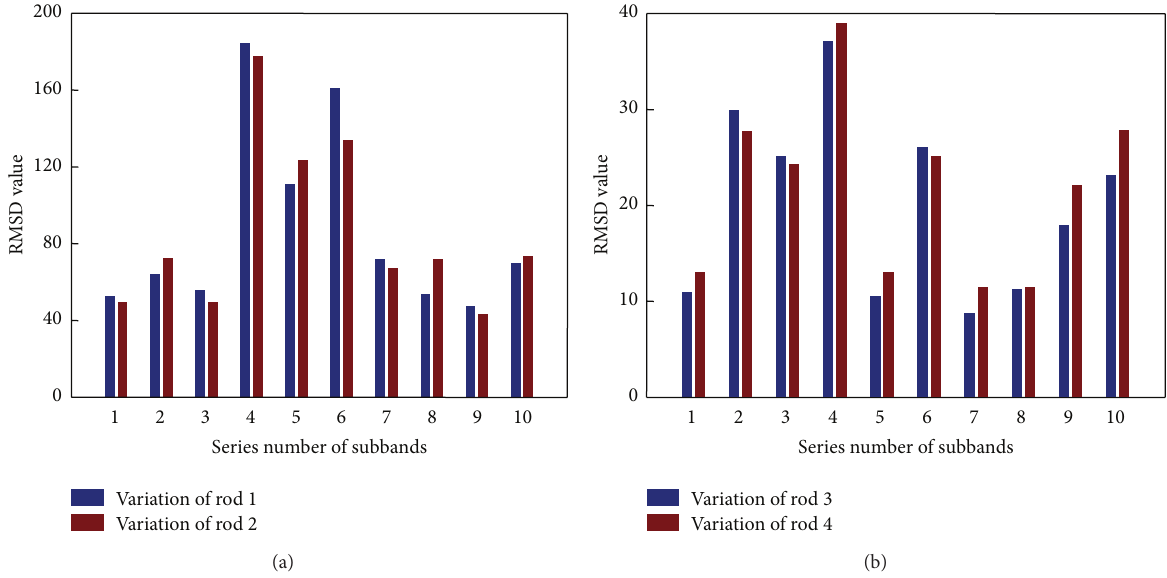
Figure 4: RMSD values calculated from different subbands when (a) rod 1 and rod 2 and (b) rod 3 and rod 4 of the truss structure were loosened to determine sensitive frequency